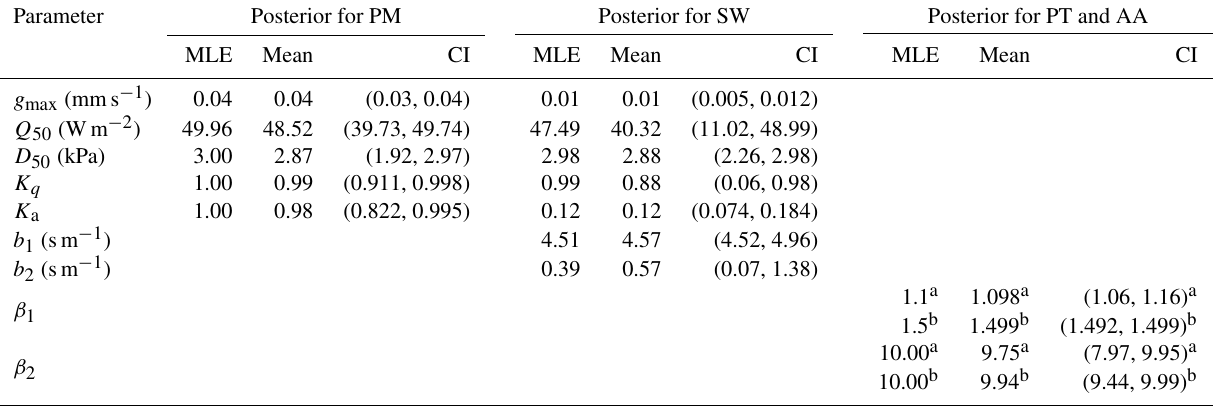
Table 2. Maximum likelihood estimates (MLEs), mean estimates, 95% high-probability intervals (lower limit, upper limit). Parameter Posterior for PM Posterior for SW Posterior for PT and AA MLE Mean CI MLE Mean CI MLE Mean CI g max (mms − 1 )